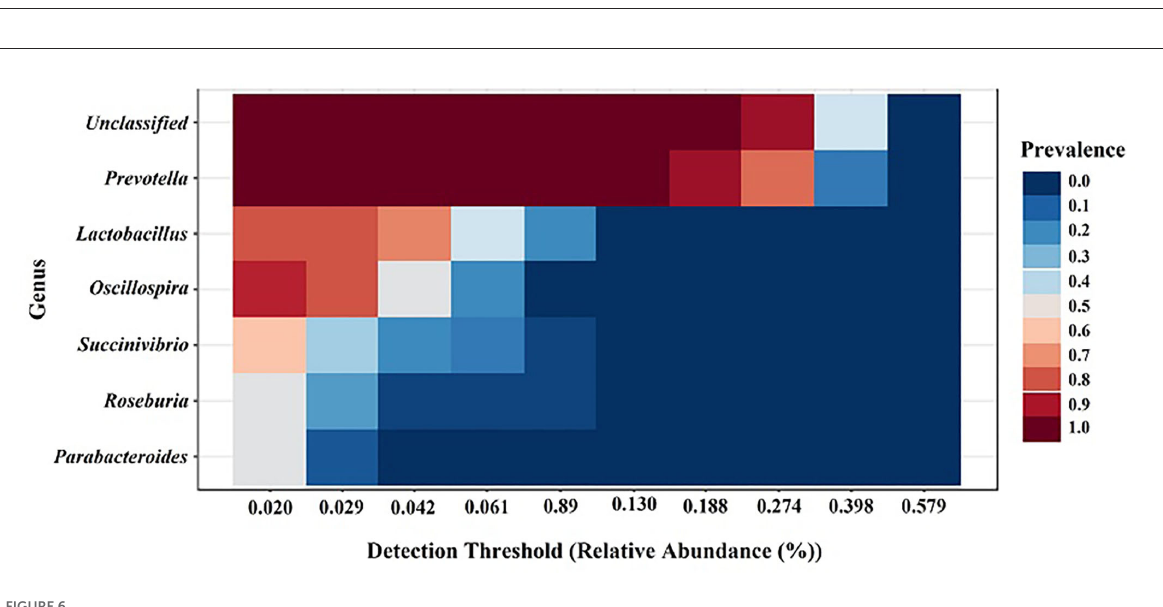
FIGURE6 Core gut microbiota among the groups regardless of treatments. Heatmap depicting the core OTUs and their prevalence at different detection